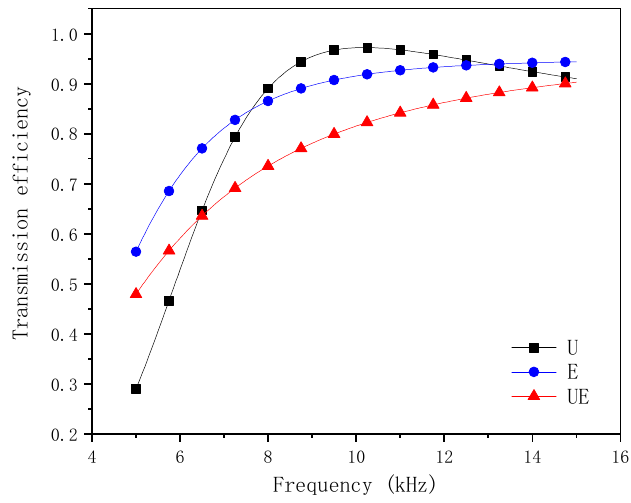
Figure 8. Transmission efficiency of ICPT system with different magnetic coupling structure.